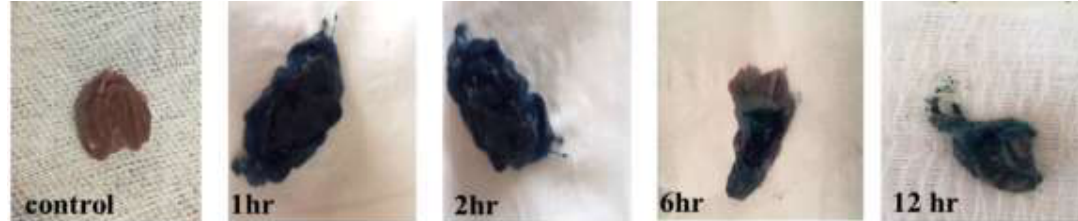
Figure 6: Images showed sectioned rat’s stomach at different periods as the F5 organogel was stained with 0.1% w/v methylene blue.